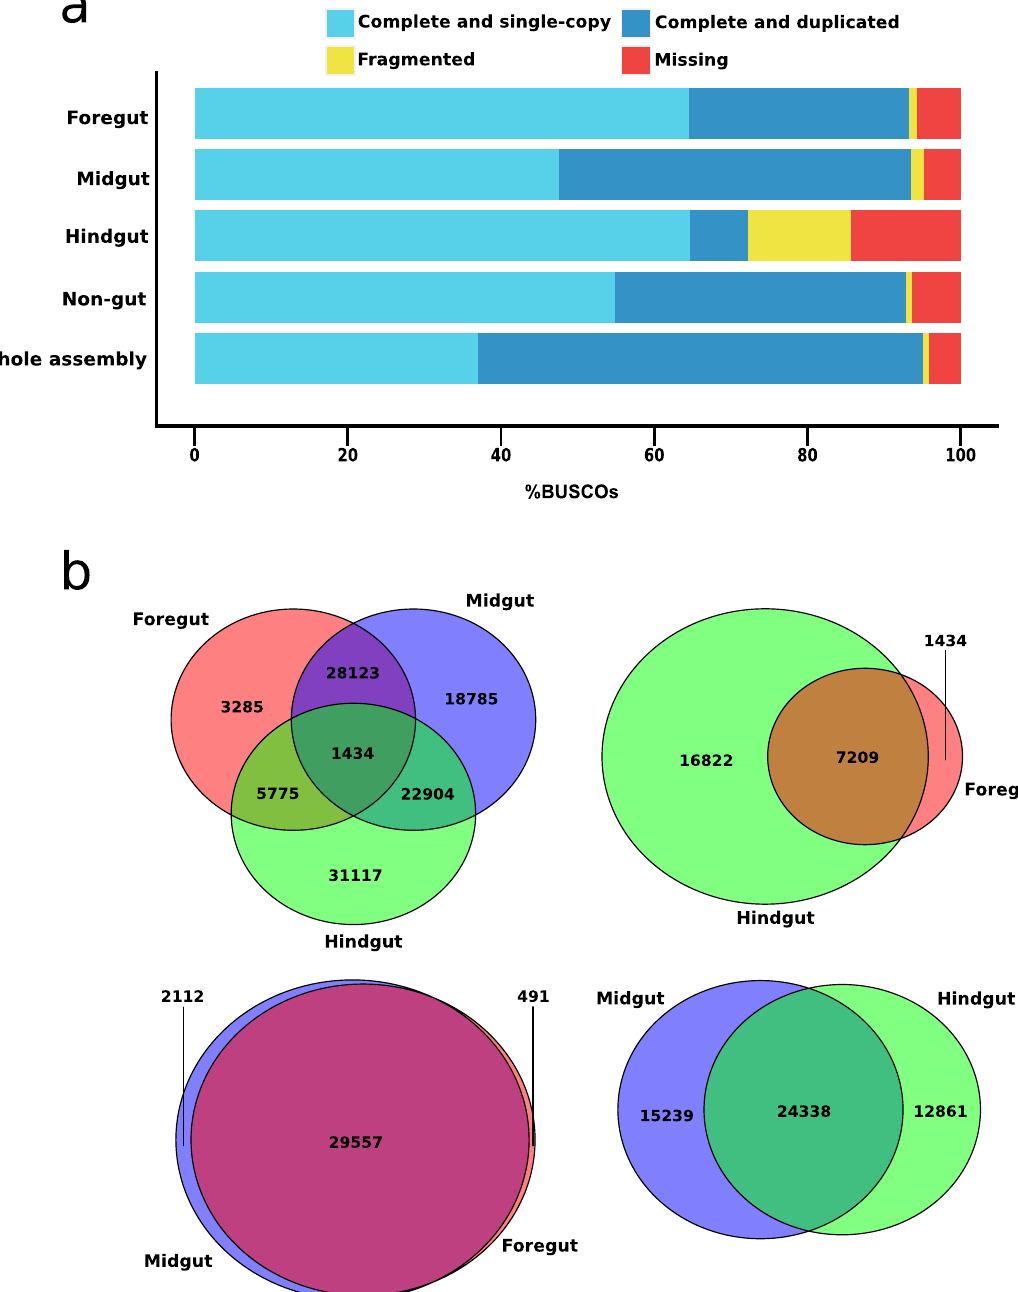
Figure 1. The assembly completeness and differential expression (DE) of transcripts are assessed in different body segments and whole assembly (combining all body segments). ( a ) Cumulative percentage of orthologs inferred from the BUSCO search using core Arthropoda genome. Complete orthologs can be either single-copy or duplicated. Incomplete orthologs are considered fragmented and, in the case of non-matching orthologs from the database, denoted as missing. ( b ) Venn diagram representing the DE analysis of transcripts from foregut, midgut, and hindgut. The Venn diagram numbers indicate either shared or unique expression data of different gut